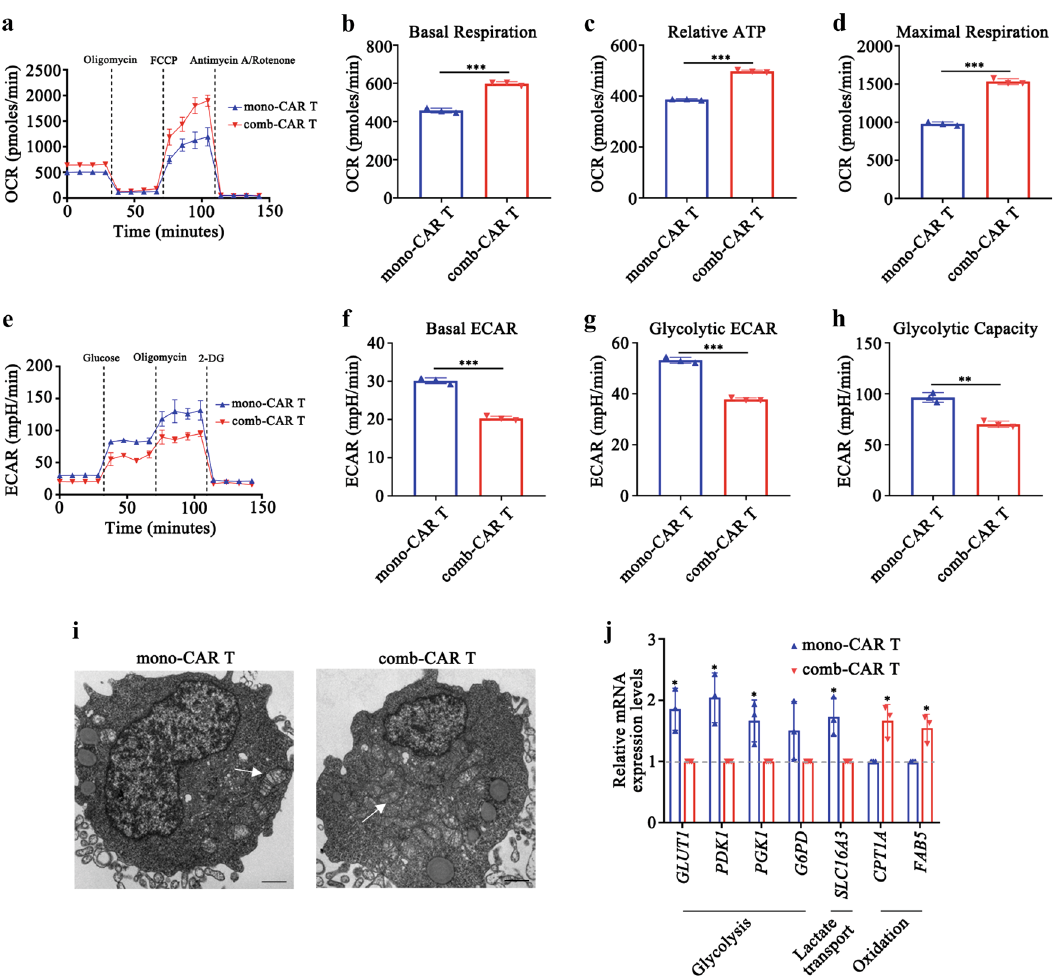
fi elds with similar results are shown ( n =3 per group). Scale bars represent 1 μ m. j Relative mRNA expression levels of genes involved in glycolytic metabolism and lipid oxidation assessed in mono- and comb-CAR T cells (GLUT1, PDK1, SLC16A3, CPT1A, FAB5: mono-CAR T vs comb-CAR T p =0.01, PGK1: mono-CAR T vs comb- CAR T p =0.03). Data are obtained over 3 biologically independent samples per group and presented as the mean±SD ( a – h , j ). Data are analysed by two-sided unpaired t -test ( b , d , f – h , j ). * p <0.05, ** p <0.01, *** p <0.001. Source data are provided as a Source Data fi